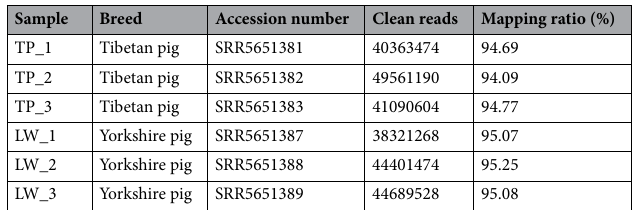
Table 1. The summary of data from RNA-seq for Tibetan (TP) and Yorkshire (LW)